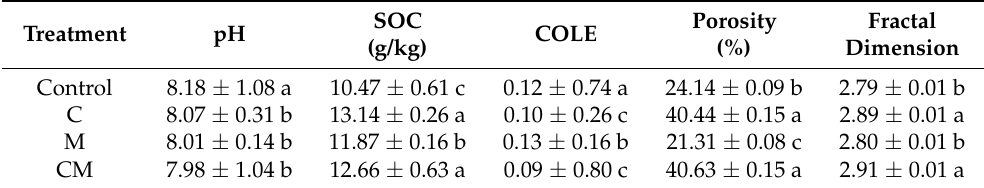
Table 3. Selected physical and chemical properties.